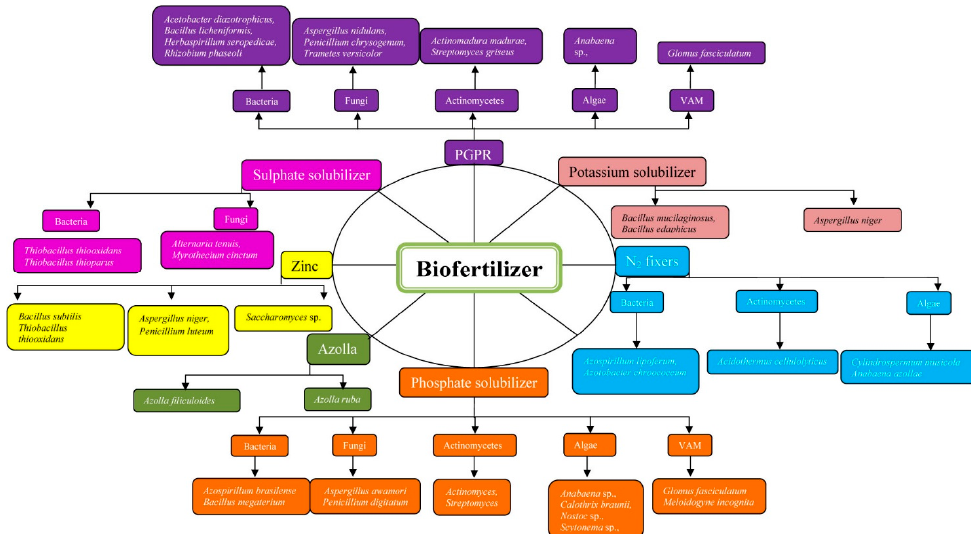
Figure 2. Biofertilizer classification and involving microorganisms.